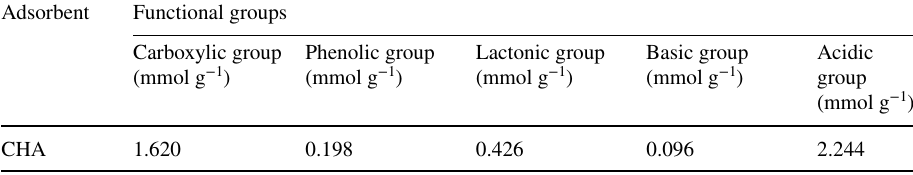
The values reported are mean of triplicates. The standard error is ±